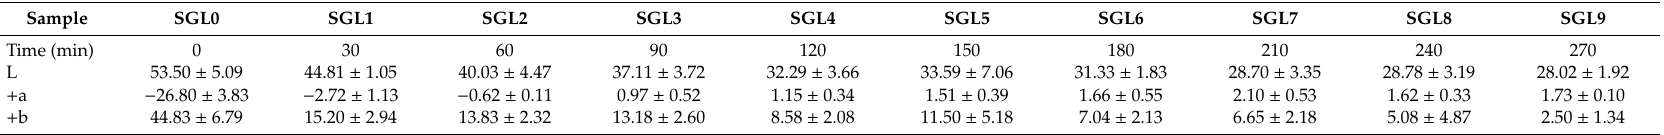
Table 1. Changes in color parameters of ginseng leaves during the steaming at di ff erent steaming